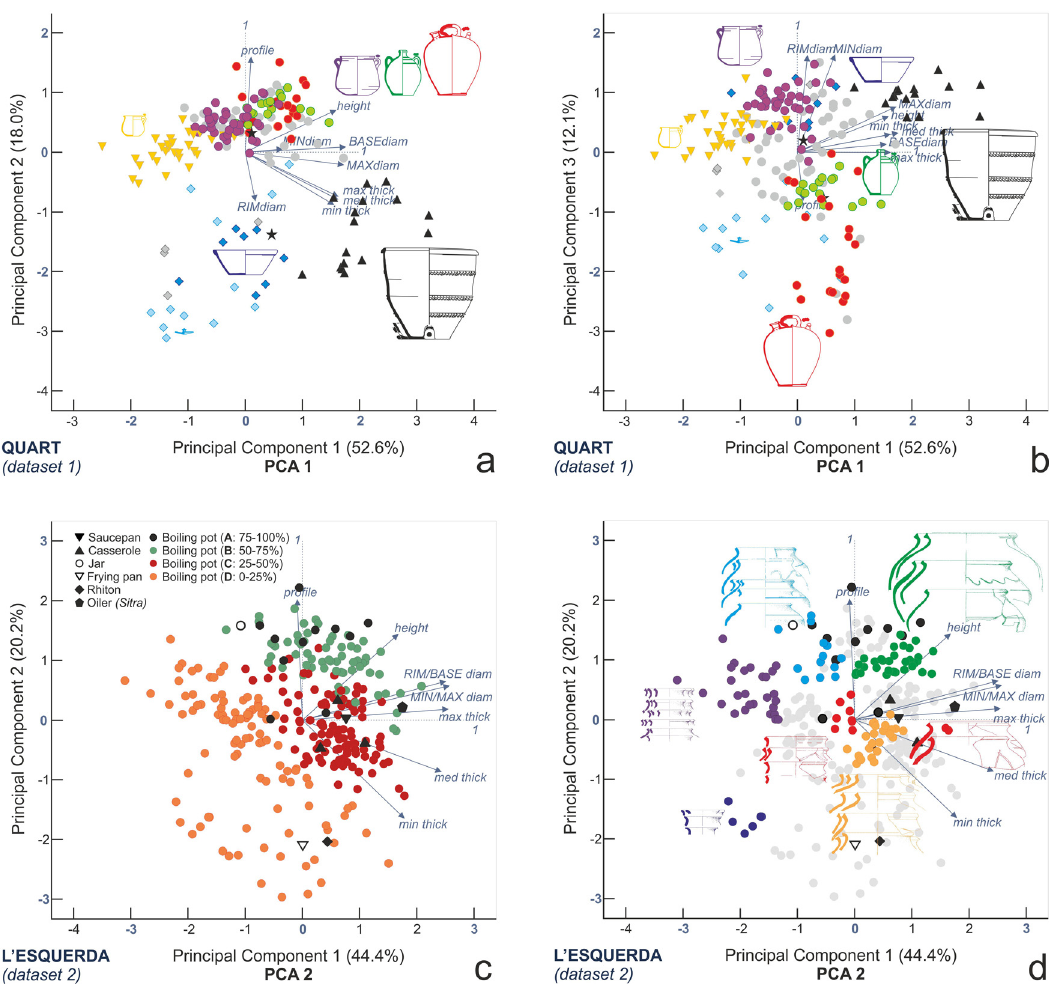
Figure 4: Scatterplots of PCA of the morphometric data of pottery samples from Quart and l ’ Esquerda. Vessel typology from Quart is identi fi ed in principal component 1 versus principal component 2 ( a ) and principal component 1 versus principal component 3 ( b ) scatterplots of PCA 1. Vessels from L ’ Esquerda plot according to their degree of breakage mainly in principal component 1 versus principal component 2 ( c ) , but typological clusters are also identi fi ed as shown in the same graph ( d )